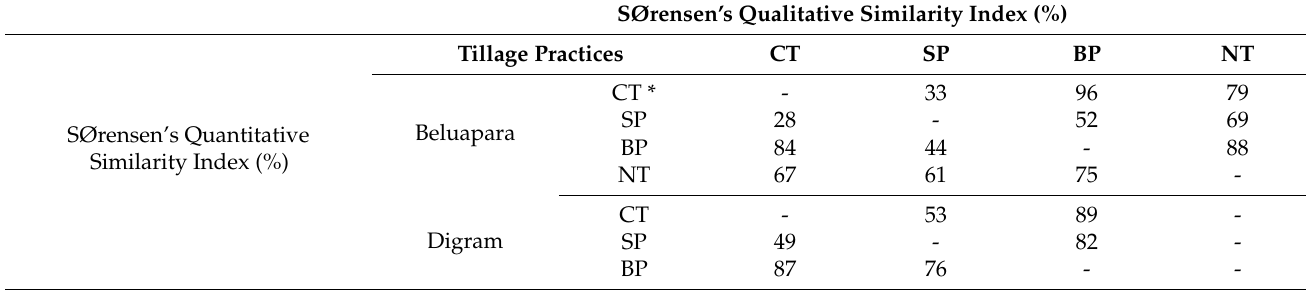
Table 3. Effect of tillage practices on the SØrensen’s qualitative and quantitative similarity index (%) of the weed seedbank after 3 years in Beluapara and 5 years in Digram.